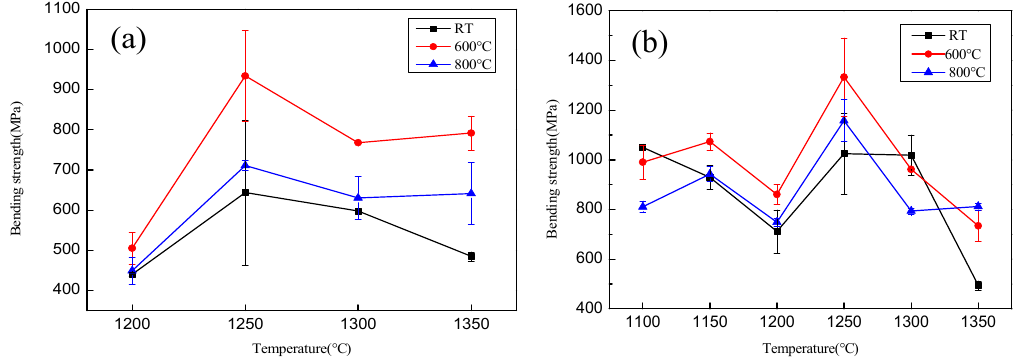
Figure 6. Curve of bending strength of Ti-48Al-2Cr-8Nb alloy with sintering temperature and ambient temperature. ( a ) Sintered by the SP powder and ( b ) sintered by the MP powder.